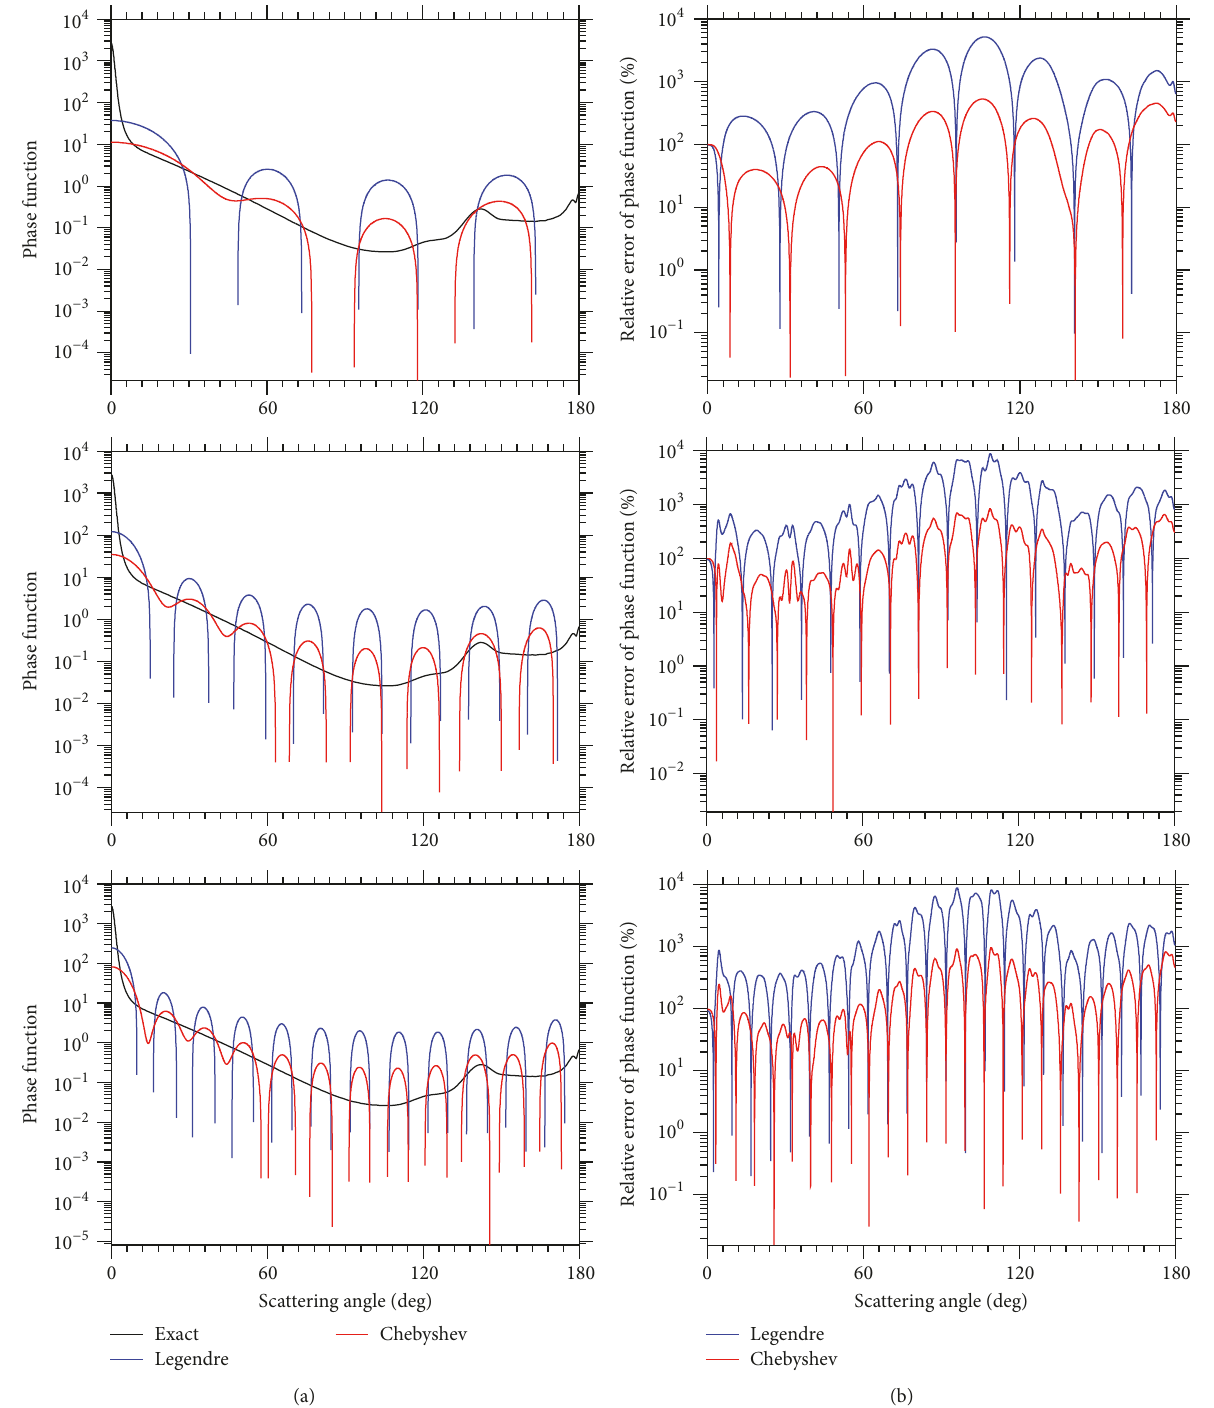
Figure 3: Phase function of water cloud (a) and relative error of phase function (b) in 8, 16, and 24 terms.